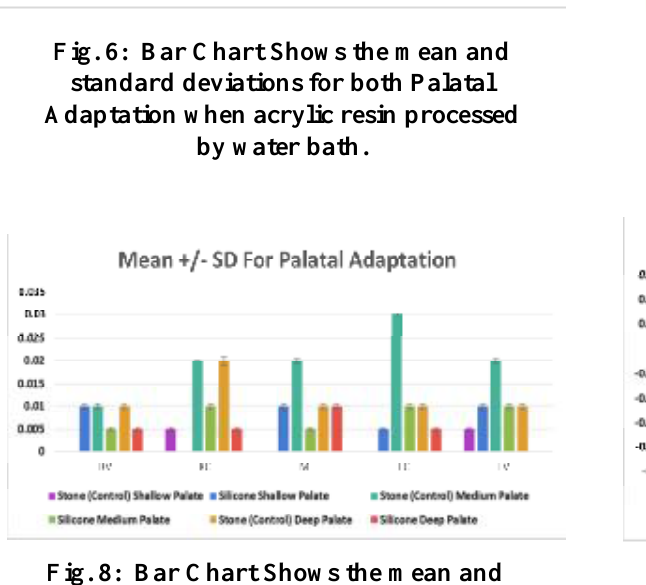
Fig. 8: Bar Chart Shows the mean and standard deviations for both Palatal Adaptation when acrylic resin processed by fast autoclave cycle.